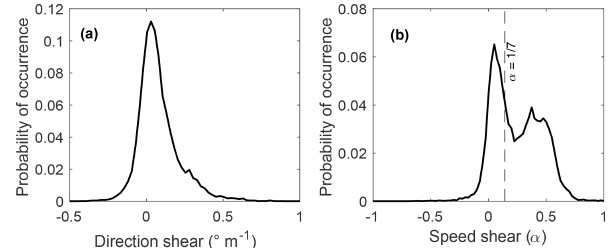
Figure 8. Wind direction (a) , and speed shear (b) evolution with height across the rotor layer.